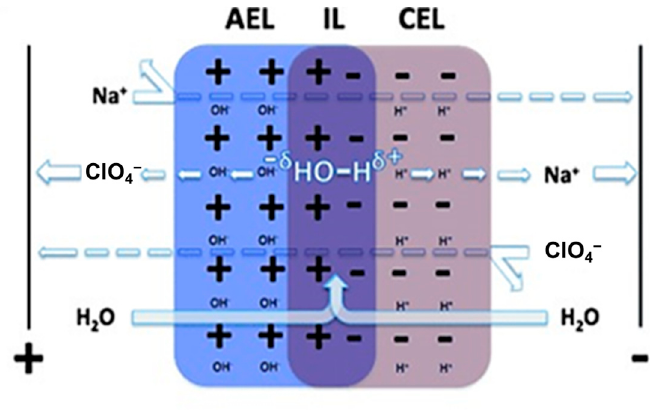
Figure 2. The bipolar membranes (BPM) configuration with base (1 M NaOH) in the anion exchange layer (AEL) as the anode and acid (1 M HClO 4 ) in the cation exchange layer (CEL) as the cathode. Thus, OH − is consumed at the anode and H + is consumed at the cathode; Na + and ClO 4 − transport is electrostatically attenuated, and the ionic current is enabled by water dissociation in the interfacial layer. Reproduced with permission from ref. [32]. Copyright 2014, Wiley ‐ VCH.